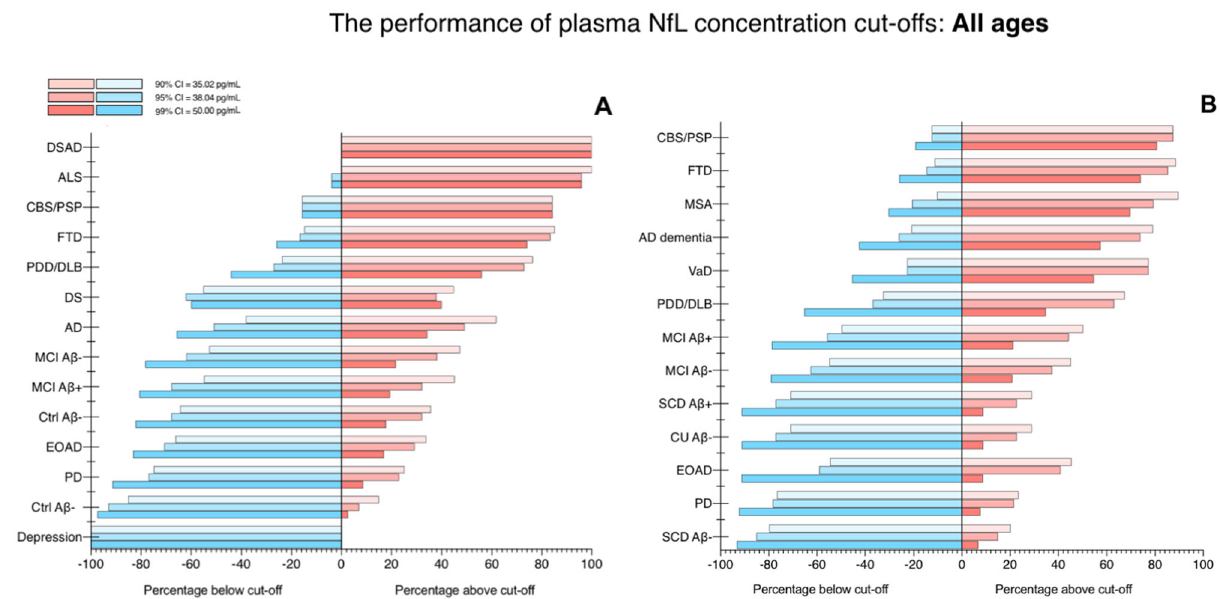
Fig. 5 The performance of plasma NfL concentration cutoffs to identify neurodegenerative disorders of all ages. The performance of plasma neuro fi lament light (NfL) concentration cutoffs to identify neurodegenerative disorders in KCL ( A ) and Lund ( B ). AD Alzheimer ’ s disease, ALS amyotrophic lateral sclerosis, CBS corticobasal syndrome, DLB dementia with Lewy bodies, DS Down syndrome, DSAD Down syndrome Alzheimer ’ s disease, EOAD early-onset Alzheimer ’ s disease, FTD frontotemporal dementia. MCI mild cognitive impairment, MSA multiple system atrophy, PD Parkinson ’ s disease, PDD Parkinson ’ s disease dementia, PSP progressive supranuclear palsy, SCD subjective cognitive decline, VaD vascular dementia.